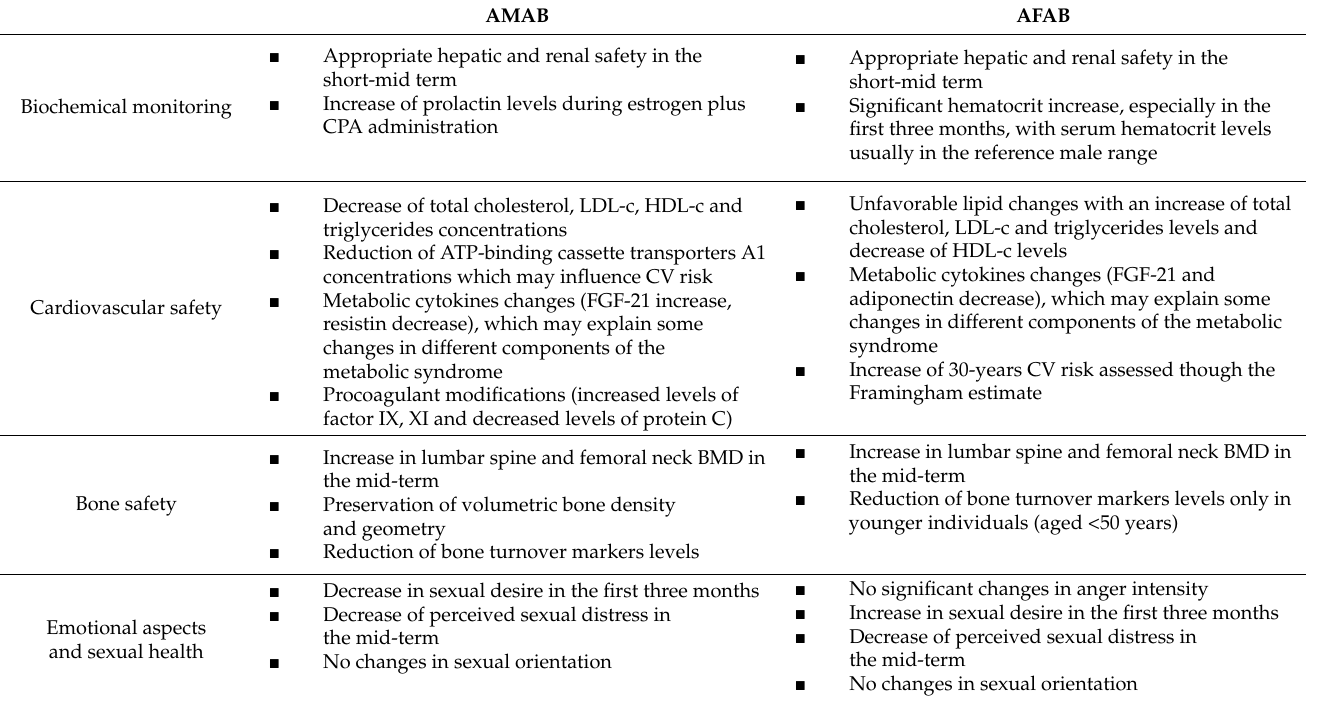
Table 3. Data on GAHT safety emerging from the ENIGI study. AMAB